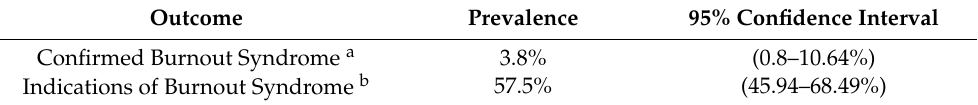
Table 3. Prevalence of burnout syndrome.